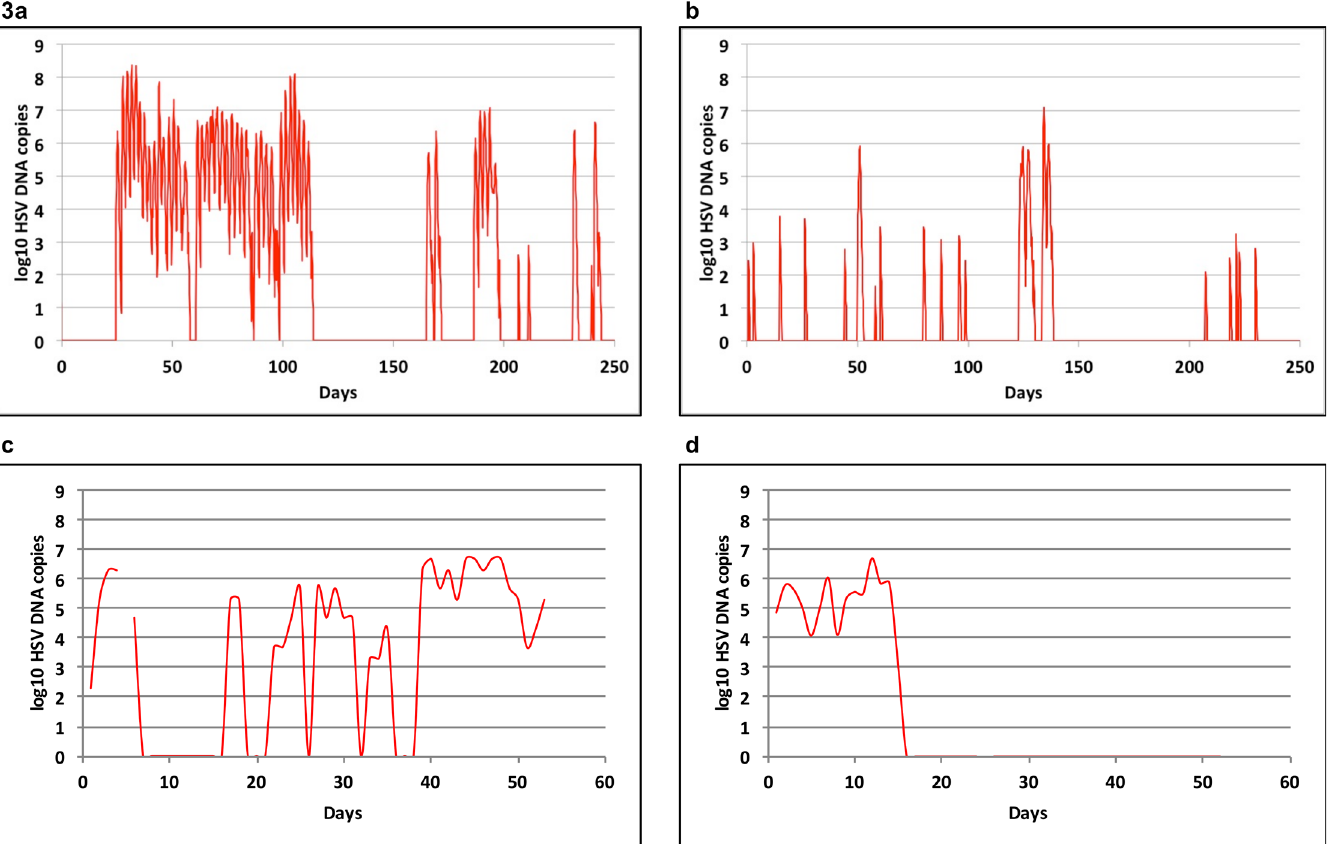
Fig 3. Increased HSV-2 shedding rate, episode rate and episode duration in HIV infected men. The red line indicates genital HSV-2 viral load over time. Model output for 300 days with parameters optimized for men with (A) HIV infection and CD4+ T-cell count < 200/ μ L and (B) no HIV infection. Data from individual study participants with (C) HIV infection and CD4+ T-cell count < 200/ μ L and (D) no HIV infection. Individuals in (C) and (D) performed daily